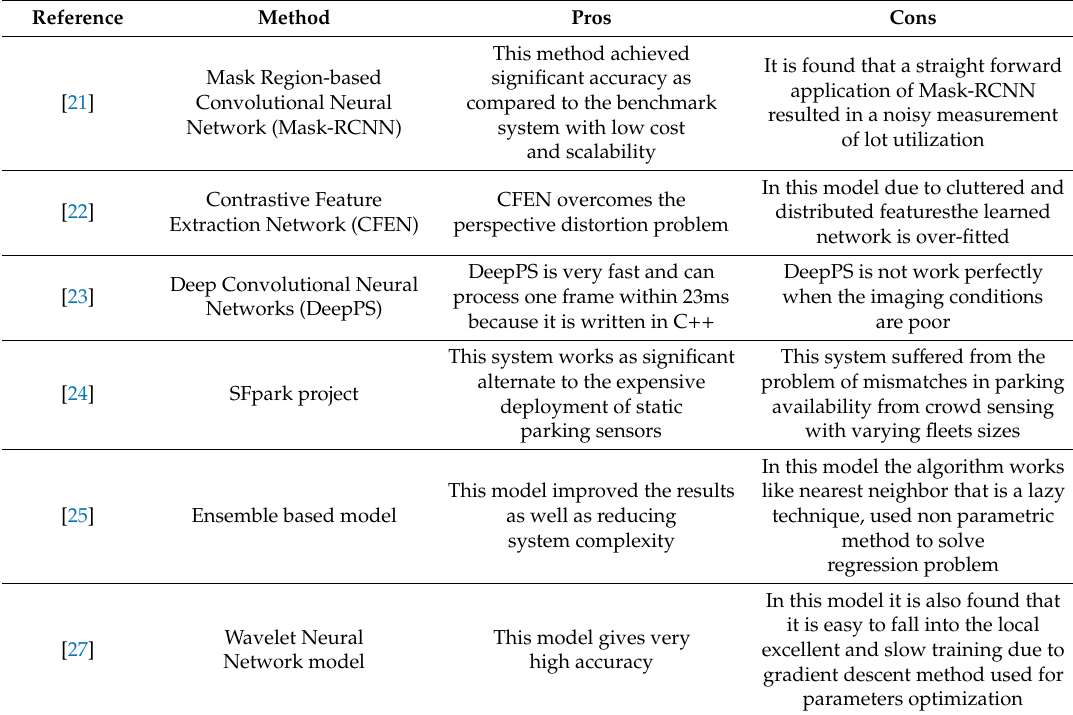
Table 1. Comprehensive of existing techniques used for smart parking occupancy